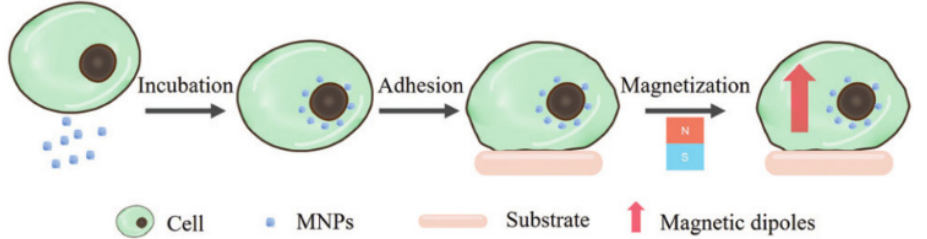
Figure 5. Schematic of intracellular magnetic labeling [43]. Reproduced with permission from the Royal Society of Chemistry. Royal Society of Chemistry.